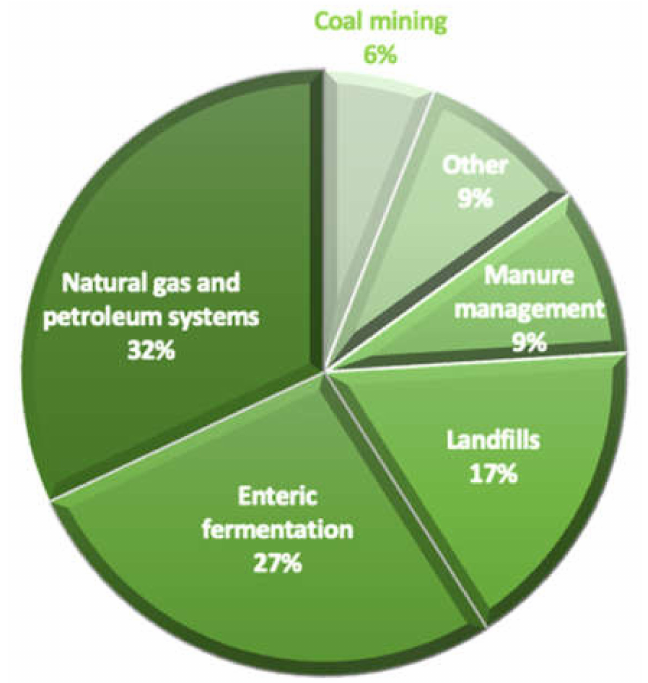
Figure 1. Source of US CH 4 emissions in